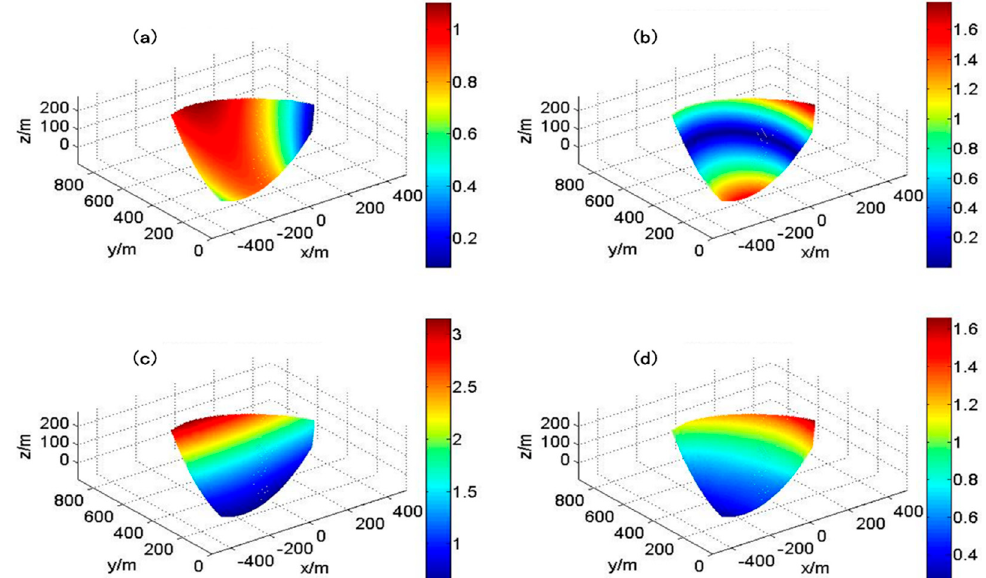
Figure 6. DEM theoretical error distributions by each error sources: ( a ) Slant range, ( b ) baseline length, ( c ) baseline angle, ( d ) in-phase.